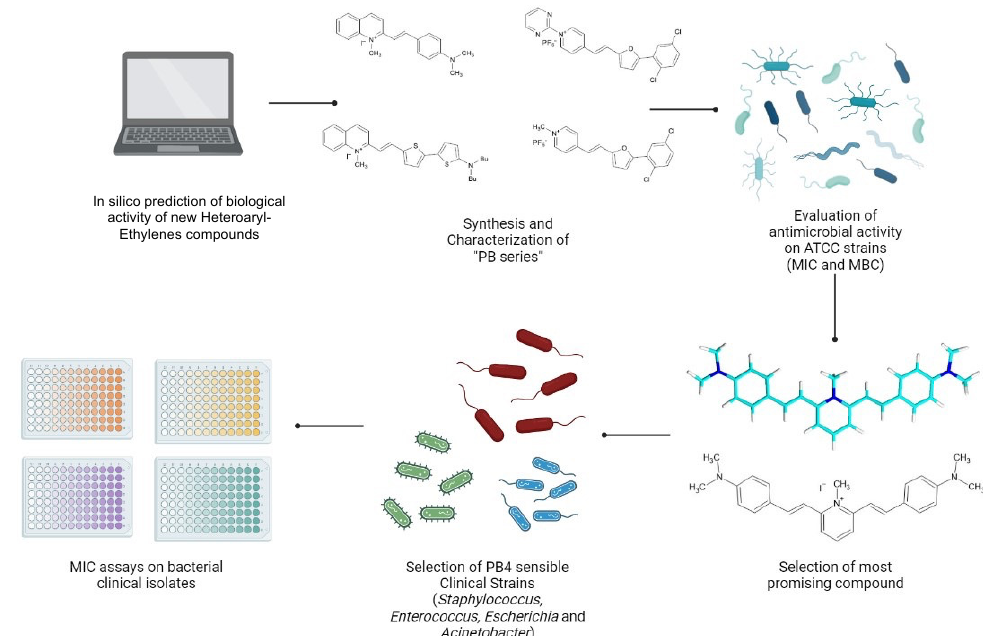
Figure 2. Experimental workflow, the figure was created using BioRender bioinformatic tool.